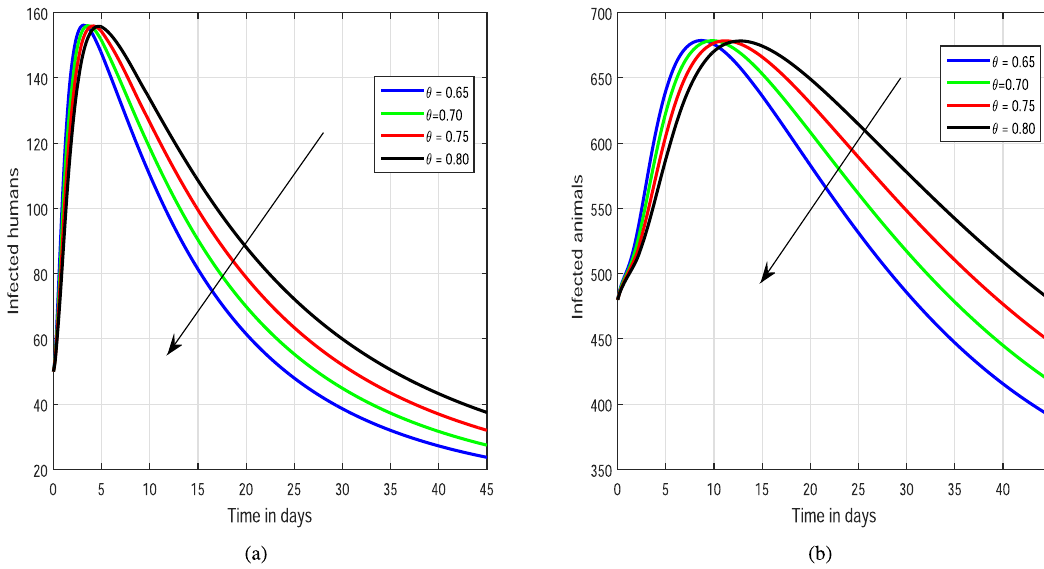
infection with variation of θ , i.e. = θ 0.65, 0.70, 0.75 , and 0.80.